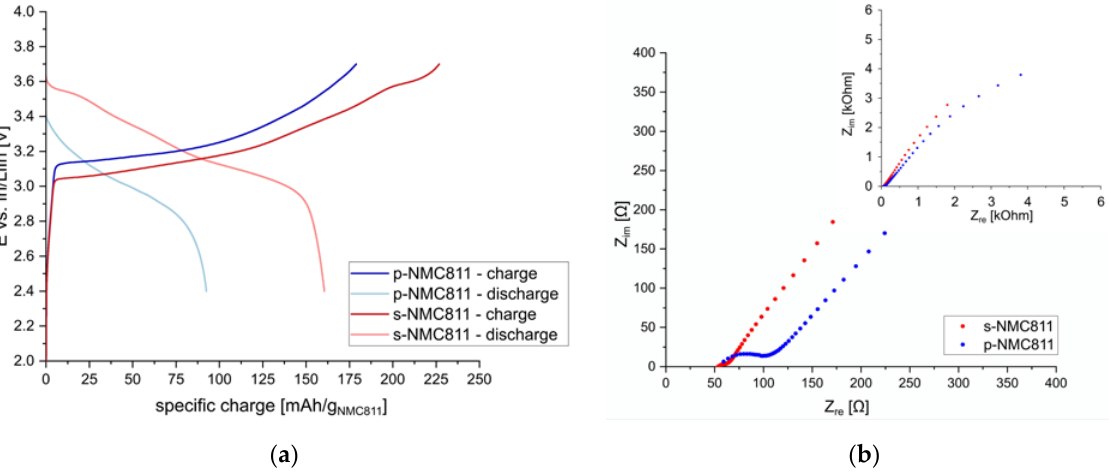
Figure 2. ( a ) Potential profiles of 1st charge/discharge cycle at C/20 using different NMC811 active materials; ( b ) EIS spectra before cycling (inset shows full range).